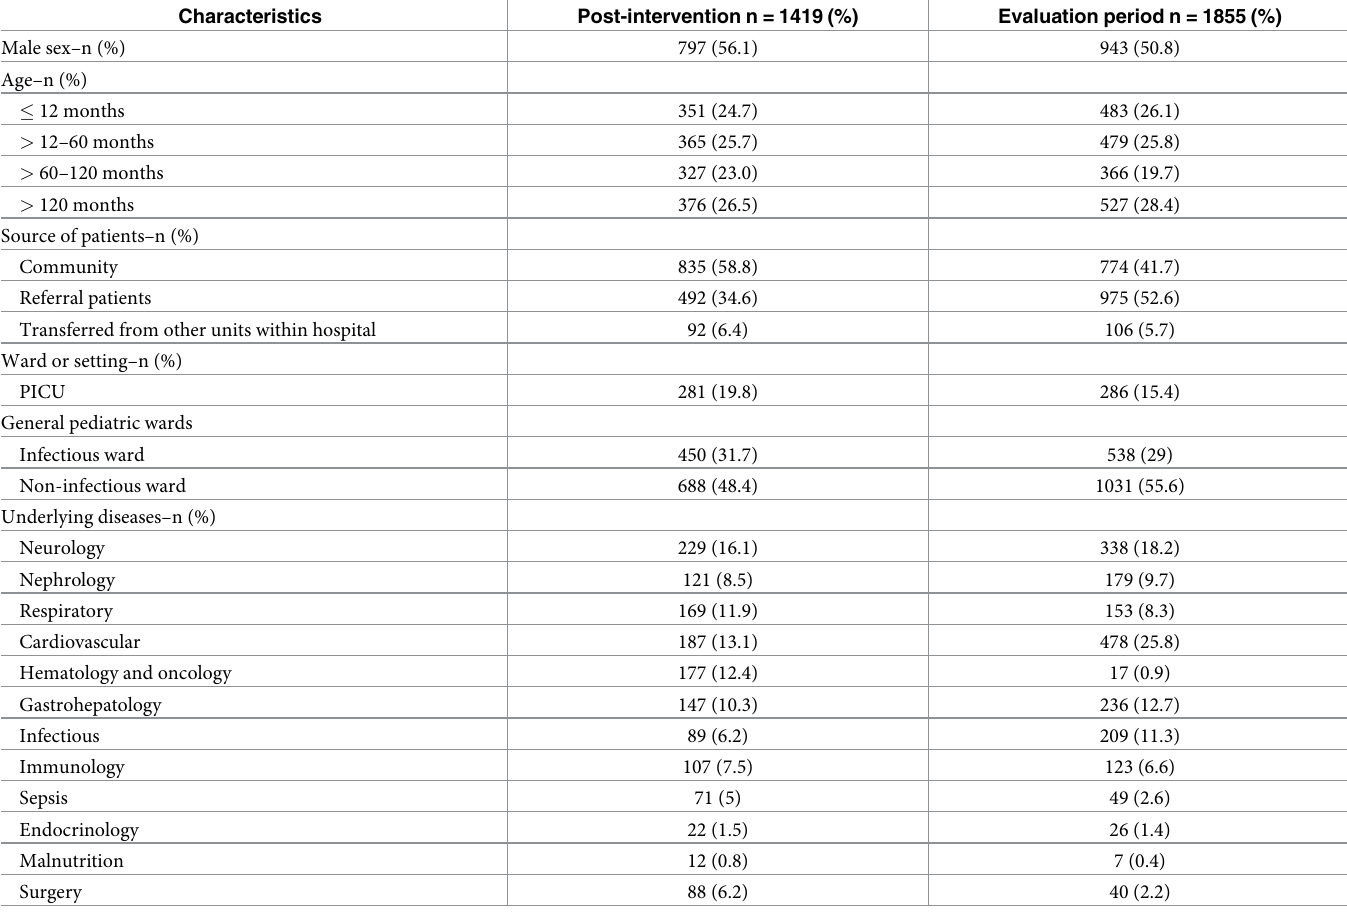
Table 2. Baseline characteristics of patients in the post-intervention and the evaluation period.